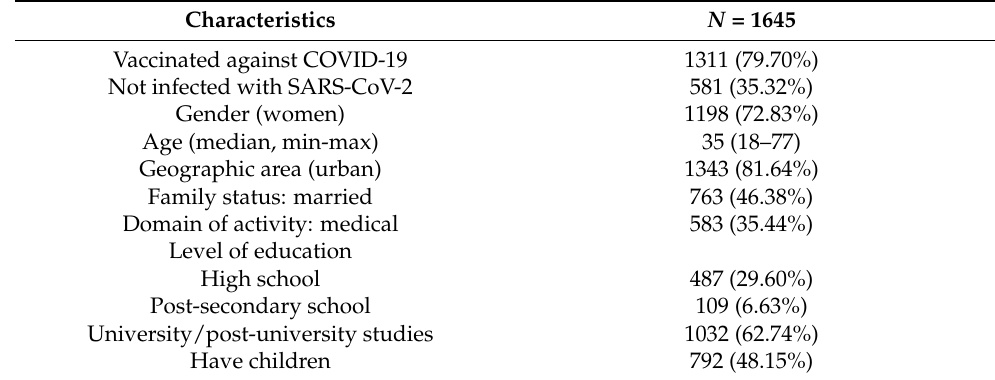
Table 1. Vaccination/infectious COVID-19 status, socio-demographic, and educational characteristics of the respondents to the questionnaire.